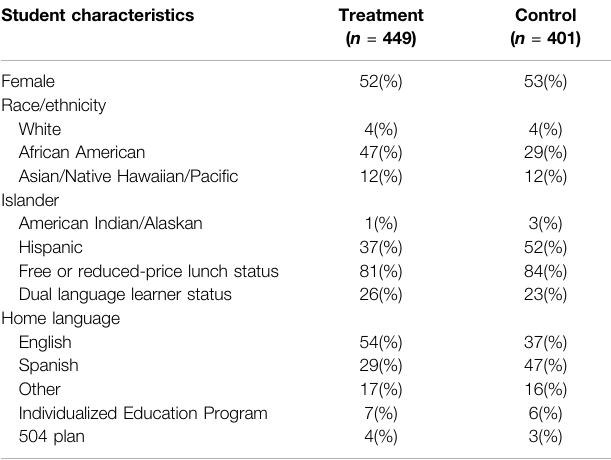
TABLE 1 | Baseline demographic characteristics of